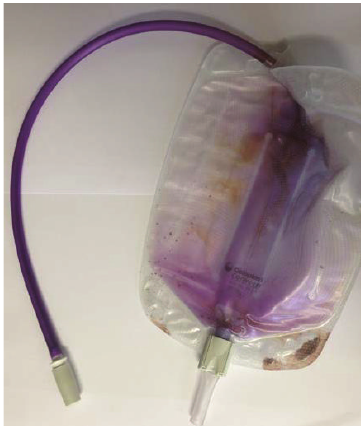
Figure 1: Purple discoloration of urine bag and tubing coming from suprapubic catheter. Note that the nephrostomy urine bag (not shown) had a normal color.